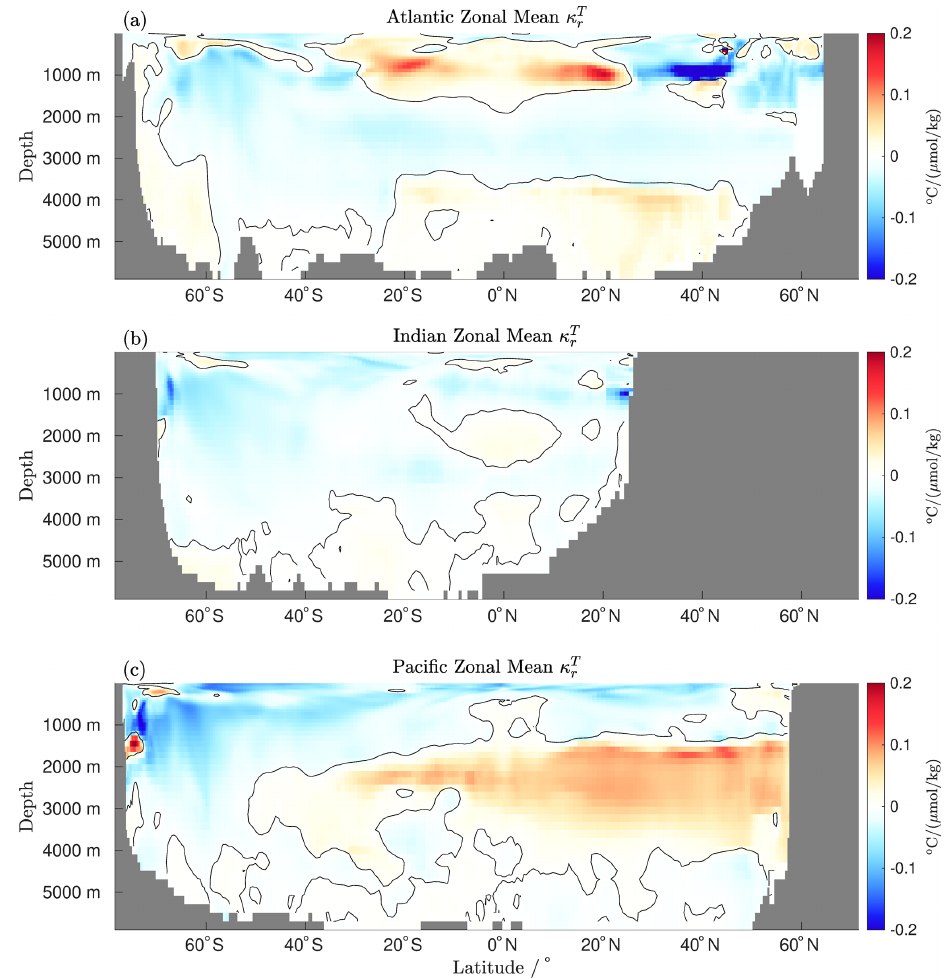
Figure D1. Zonal mean κ T r values for the Atlantic (a) , the Indian Ocean (b) , and the Pacific (c) . Ocean Sci., 18, 523–548,